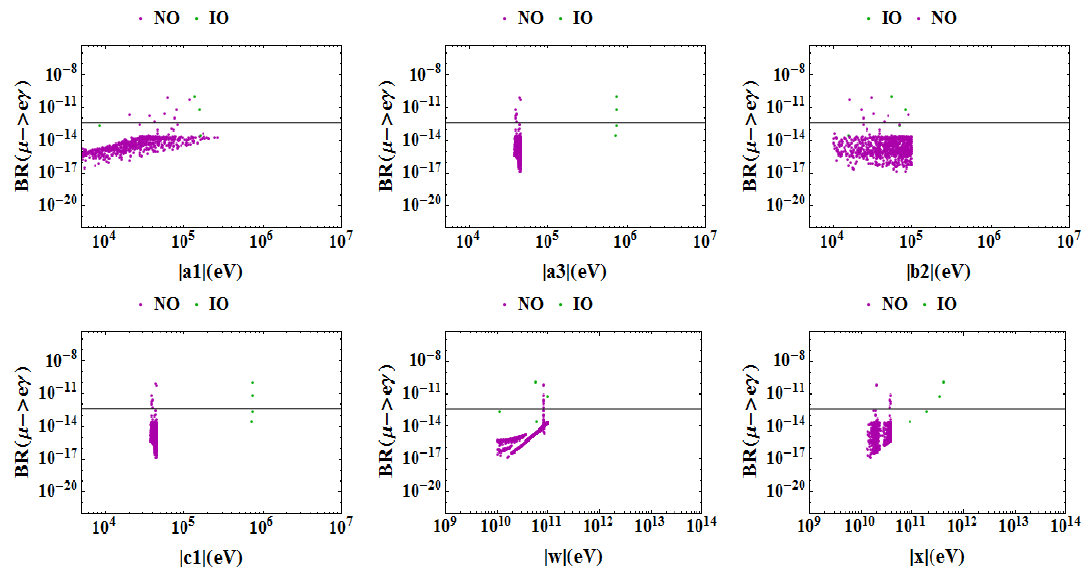
Figure 26 . BR for (cid:22) ! e (cid:13) as a function of model parameters for the class B1. The horizontal line represents the upper limit for BR given by MEG experiment. Figure 27 . BR for (cid:22) ! e (cid:13) as a function of model parameters for the class B2. The horizontal line represents the upper limit for BR given by MEG experiment. { 32